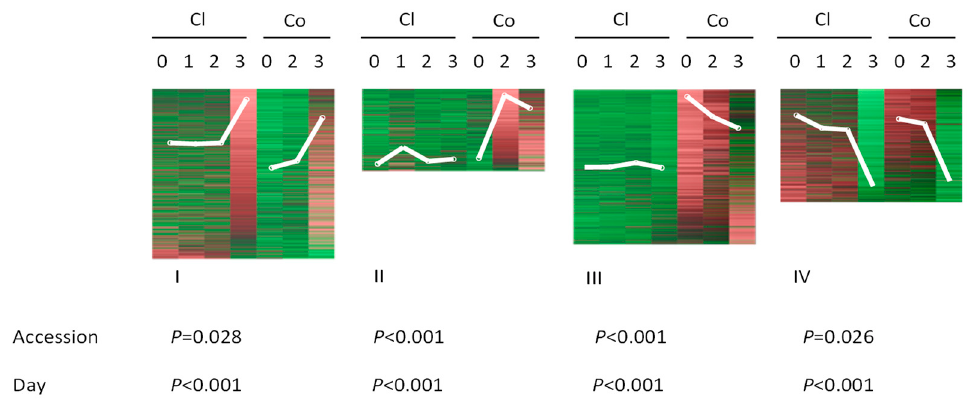
Figure 2. Regulation of gene expression by feeding of spider mites ( Tetranychus urticae ) during one, two or three days in two cucumber accessions (Chinese long (Cl) and Corona (Co), upper part) and effects of accessions and days of feeding on the expression of the differentially expressed genes (DEGs) (( p -value), lower part). All DEGs were self-organized using GeneMaths XT (http://www.applied-maths.com) into four groups (I to IV) based on their expression at different time points of feeding. White lines indicate the general expression trend for each group. DEGs from each group were tested separately using a general linear model (GLM) (IBM SPSS STATISTICS, version 22). Upregulated or downregulated abundance of transcripts was set as variable and the accessions and days of feeding by spider mites were set as factors for which the effect was tested. Table 1. Number (Nr) of TF genes belonging to different classes/families that are differentially regulated by spider-mite feeding and downy mildew infection or are regulated by both biotic stresses. Spider Downy Spider Mites and Downy Spider Mites Mildew Mildew